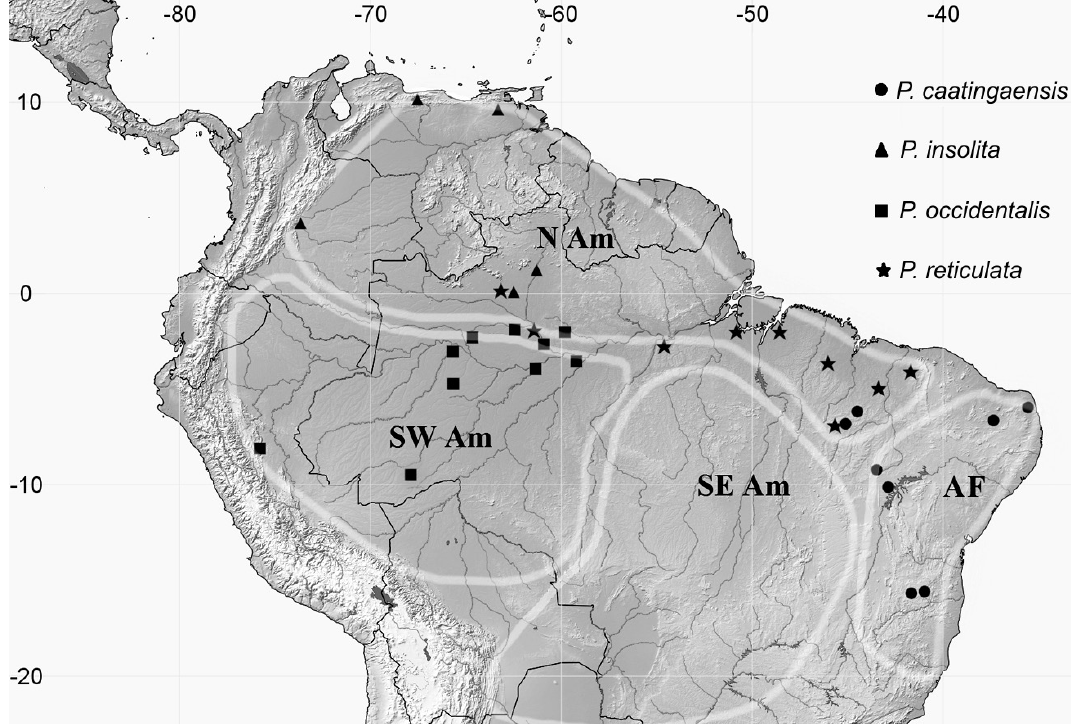
Figure 35. Map of the geographic records for species of Paraphotina with areas of endemism proposed by A morim (2009). Note that geo- graphical records of P. reticulata include transition areas for each of the other three species. (AF) Atlantic Forest; (N Am) North Amazon; (SE Am) South East Amazon; (SW Am) South West